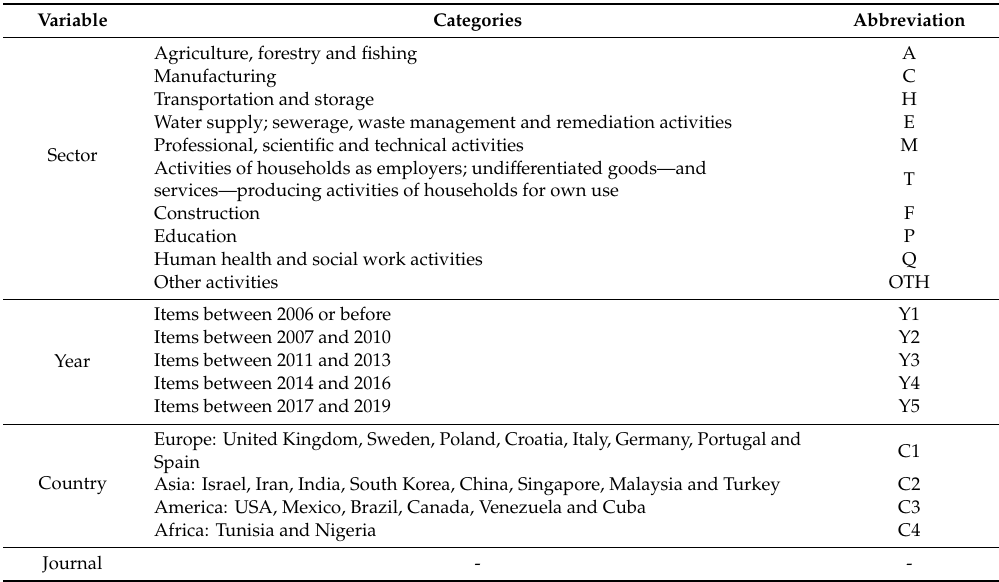
Table 1. Variables, categories, and